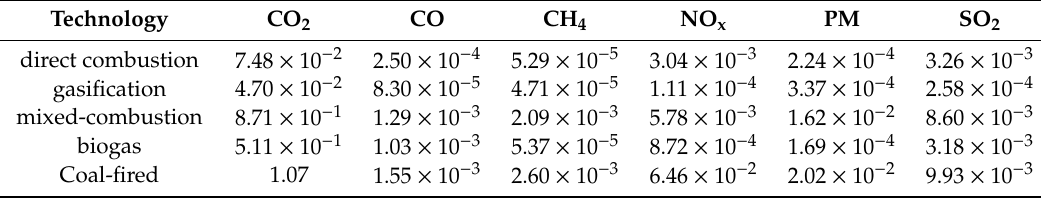
Table 1. Life cycle list of di ff erent generation technologies, kg /